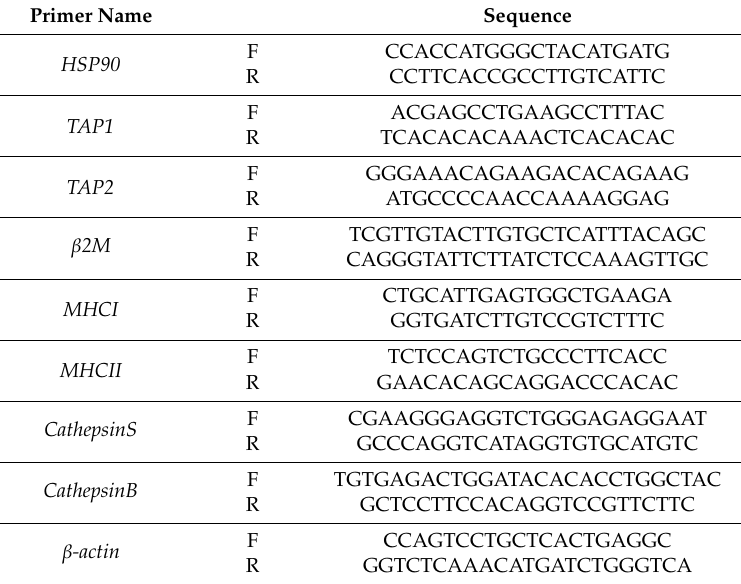
Table 1. Primer sequences for real time (RT) PCR.